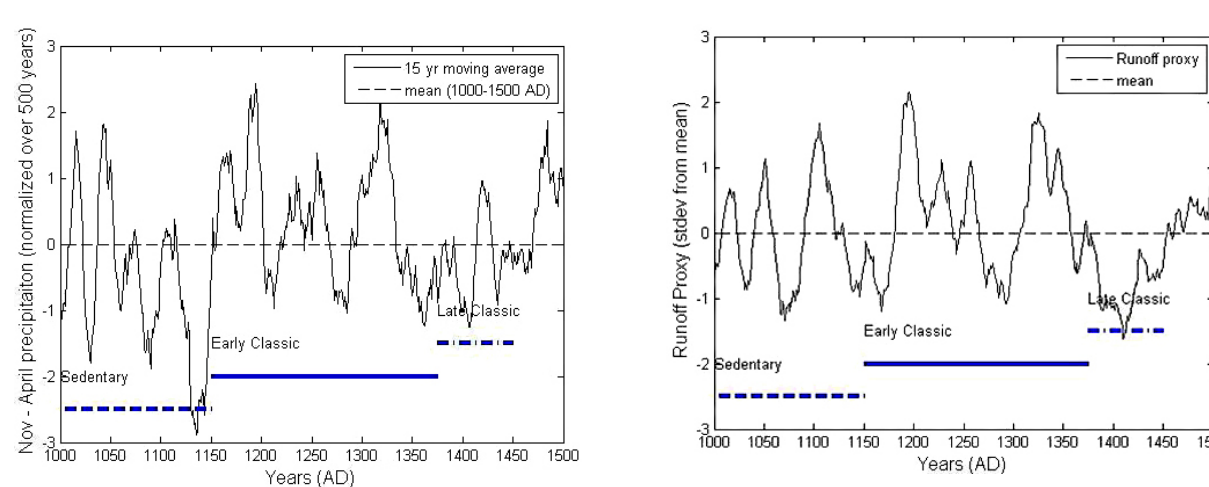
Fig. 13. The reconstructed and standardized (i.e., subtracting the mean and dividing by the standard deviation of the time series) winter precipitation (southwestern AZ, US) over the period of AD1000–1500. The sharp drop of 3 standard deviations in winter season precipitation is evident around the transition of sedentary to early classic Hohokam. Compiled from http://www.ncdc.noaa.gov/ paleo/pubs/ni2002/az6.html, see also Ni et al. (2002).